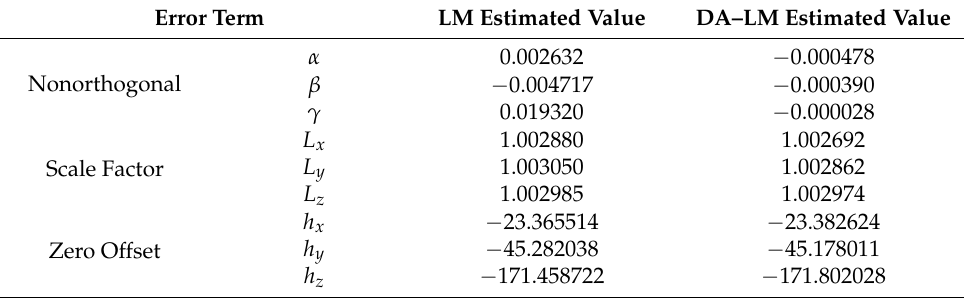
Table 3. Comparison of statistical characteristics before and after DA–LM